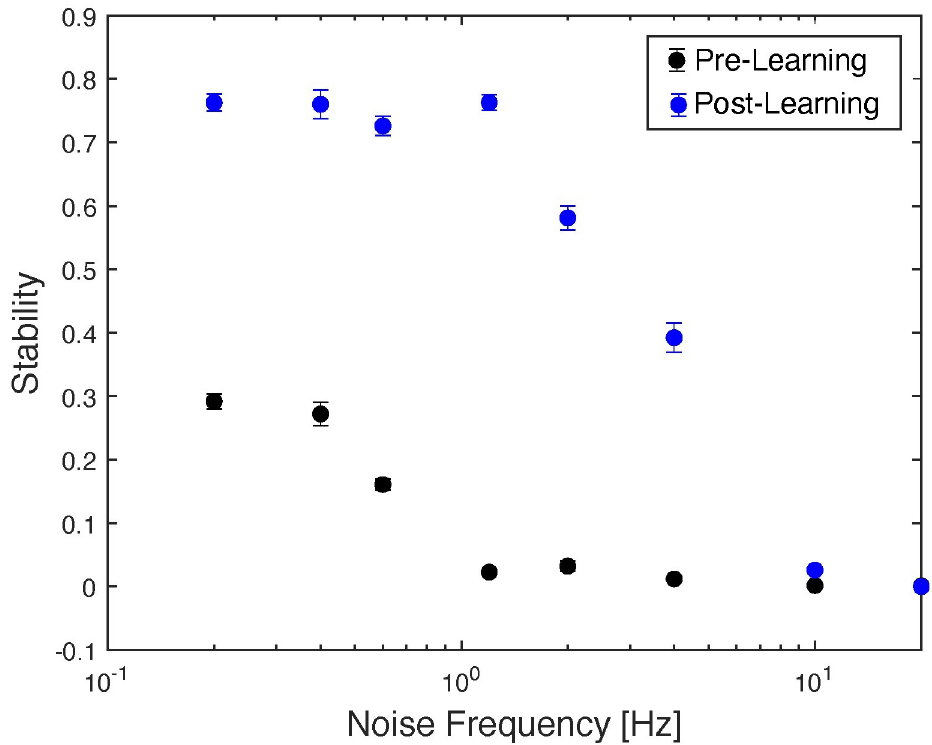
Fig 7. STDP driven NREM-like memory consolidation results in an increased stability of the network dynamics across wide range of noise levels in the network. Black dots–dynamics of the network prior STDP driven NREM-like memory consolidation. Blue dots—network dynamics post STDP driven NREM-like memory